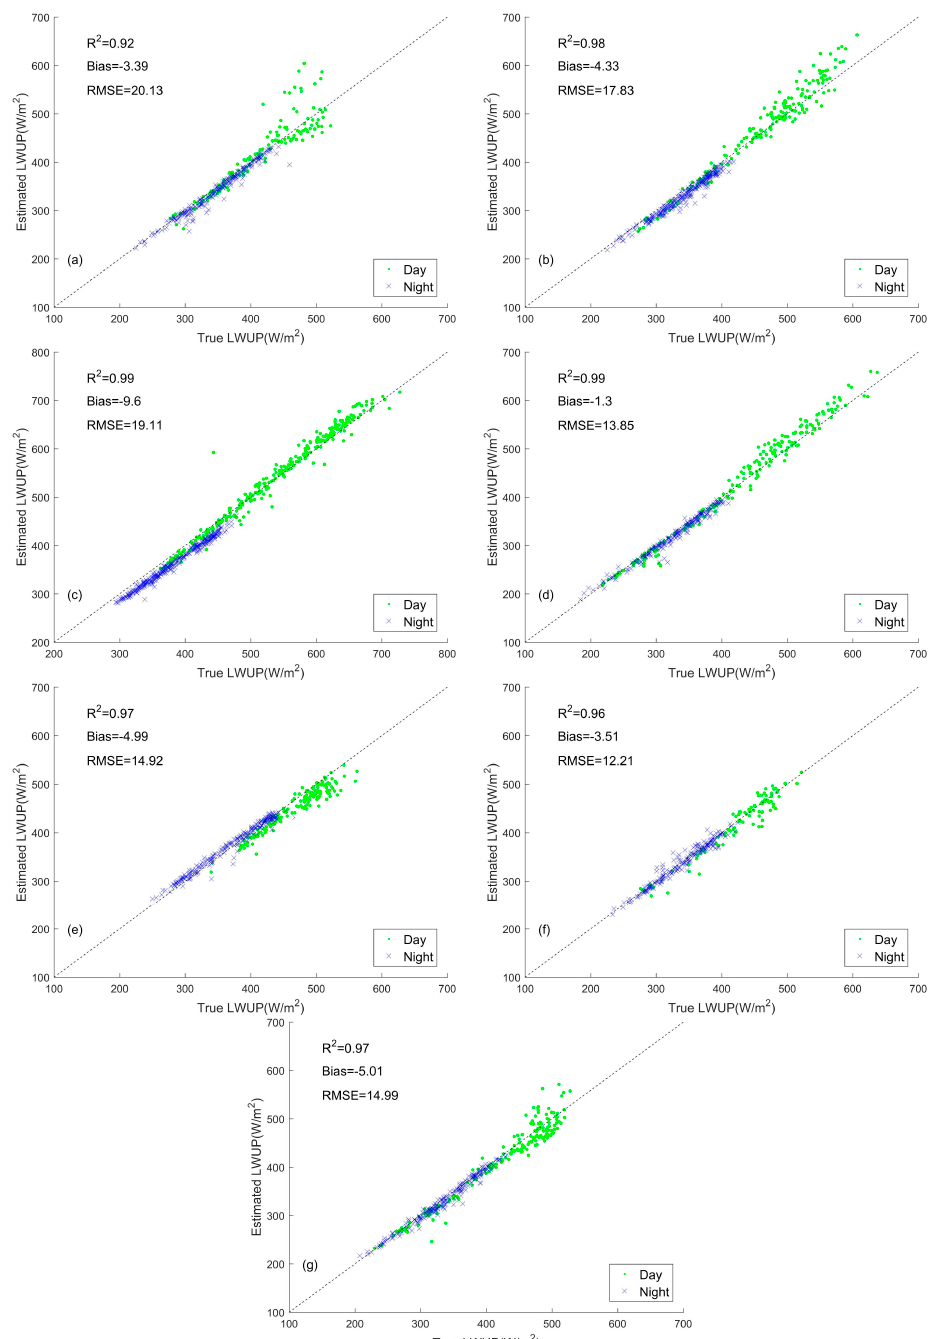
Figure 3. Validation results of the linear model at SURFRAD sites. ( a ) Bondville_IL; ( b ) Boulder_CO; ( c ) Desert_Rock_NV; ( d ) Fort_Peck_MT; ( e ) Goodwin_Creek_MS; ( f ) Penn_State_PA; ( g ) Sioux_Falls_SD.